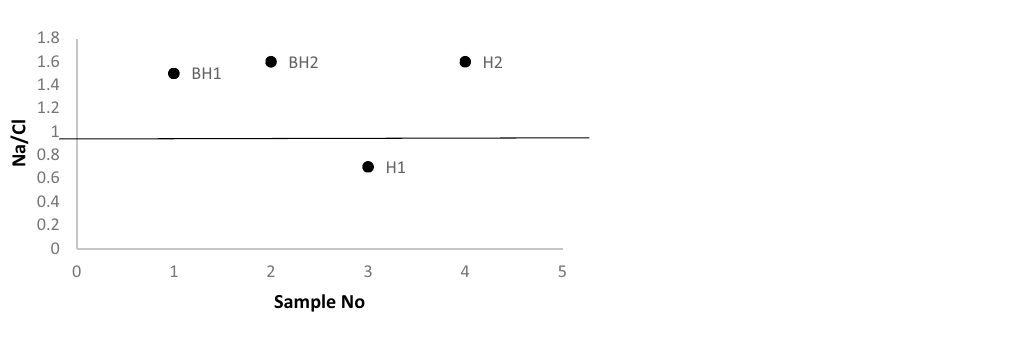
Figure 5. Plot showing Na/Cl